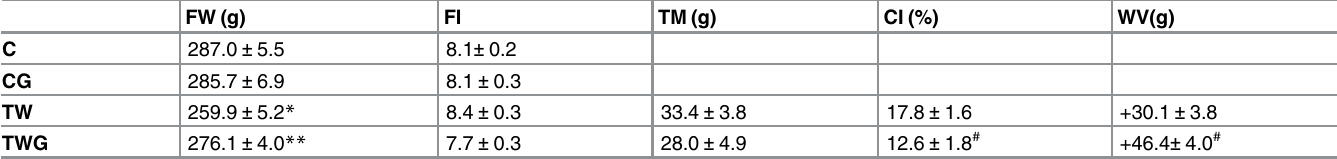
Values expressed as mean expressed as mean ± SEM CI (%) = (initial body mass — fi nal body mass + tumor mass + weight body mass gain of control)/(initial body mass + body mass gain of control)] × 100% [5] FI = g/100g weight body/day + represents positive weight variation * Indicates a signi fi cant difference when compared with C group (p < 0.05) by analysis of variance (two-way ANOVA) followed by Tukey's post hoc test ** Indicates a signi fi cant difference from TW group (p < 0.05) determined by ANOVA (two-way) followed by Tukey's post hoc test # Indicates a signi fi cant difference from TW group (p < 0.05) according student t